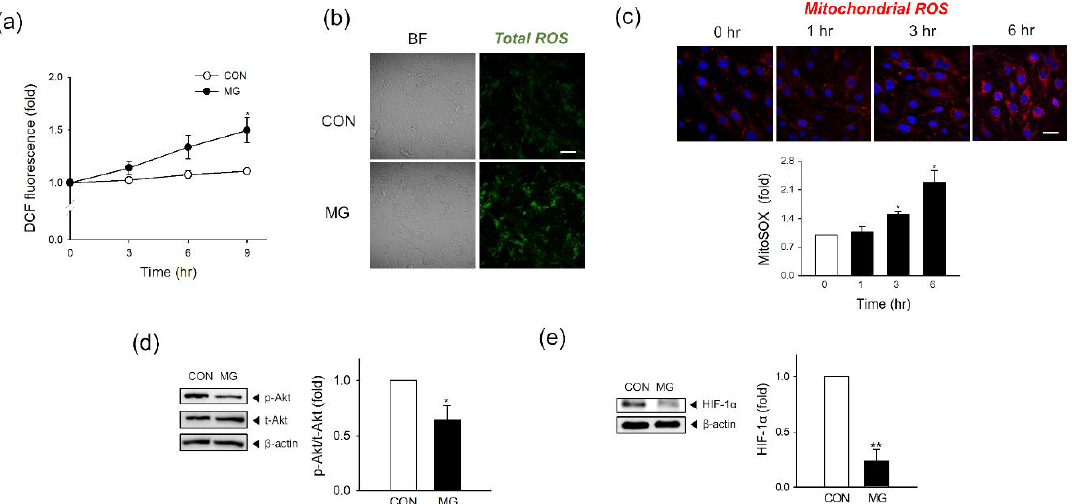
Figure 2. Total cellular and mitochondrial reactive oxygen species (ROS) production and suppression of the Akt/HIF- 1α pathway after MG exposure. ( a ) Total ROS formation was detected in DCF-DA-stained bEND.3 cells at the indicated times ( n = 3). ( b ) Confocal microscopy images of DCF-DA-stained bEND.3 cells 24 h after MG treatment. Scale bar: 20 μm. ( n = 3). ( c ) Mitochondrial ROS formation was measured at 0, 1, 3, and 6 h after MG treatment by confocal microscopy. Scale bar: 20 μm. Fluorescence was quantified from three independent experiments. ( n = 3). Representative images are shown. ( d , e ) The protein levels of ( d ) phosphorylated and total Akt (p-Akt and t-Akt) and ( e ) HIF-1α were determined by western blotting. Protein levels were normalized to β -actin levels ( n = 3). Data are presented as the mean ± SEM. * p < 0.05, ** p < 0.01 vs. control (CON).